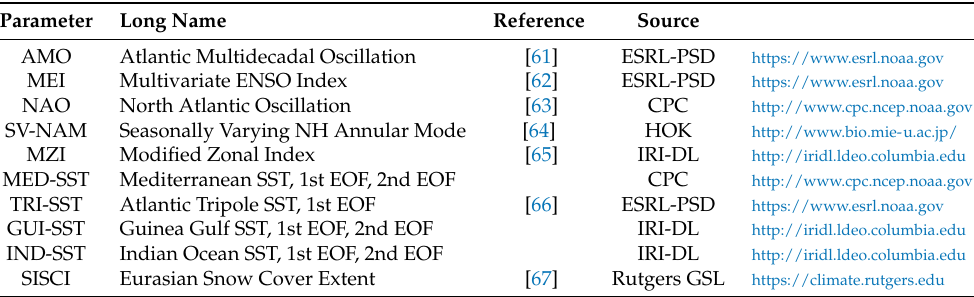
Table 3. Climatic indices identified as possible